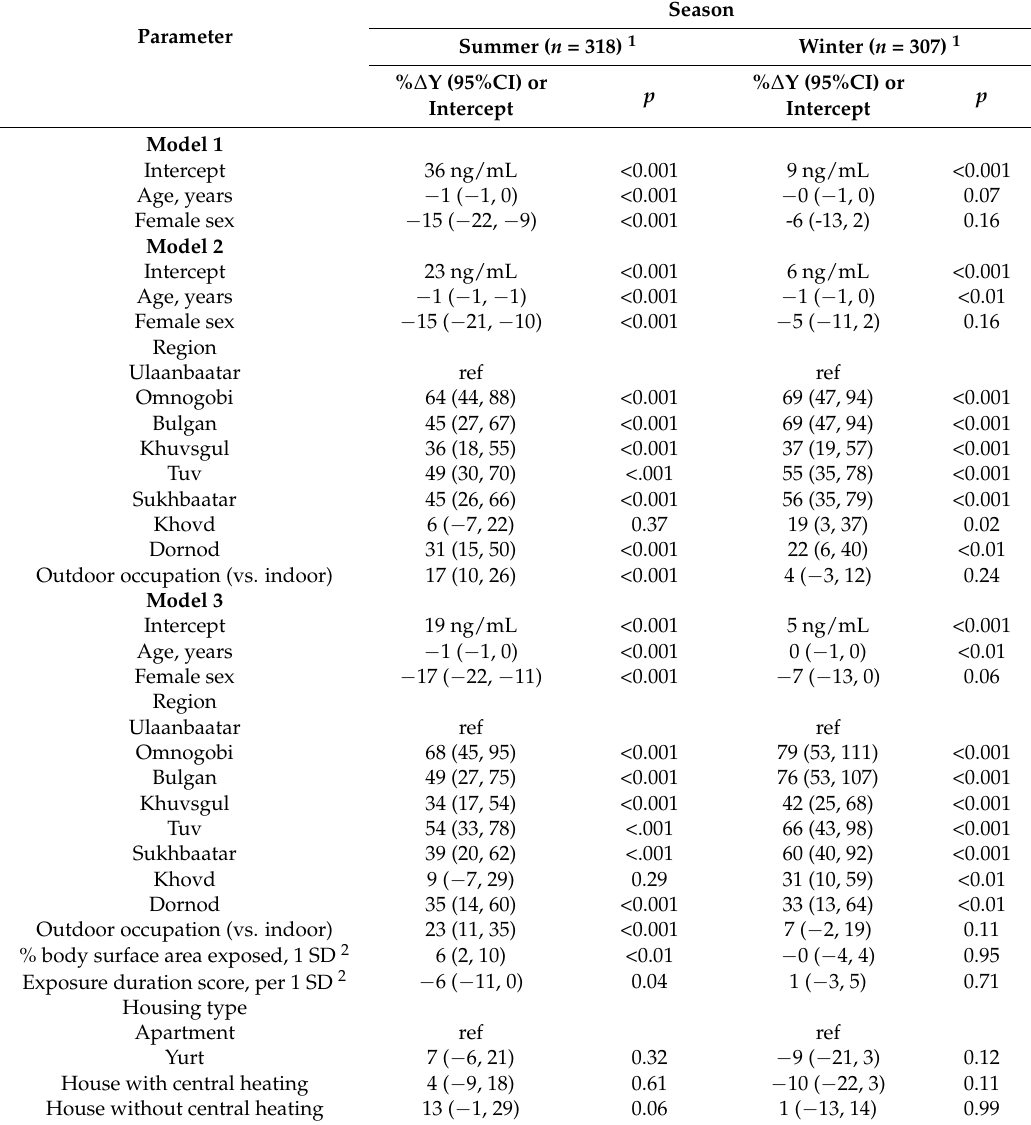
Table 4. Multivariable adjusted percent differences in 25(OH)D concentration by exposure to demographic and seasonal